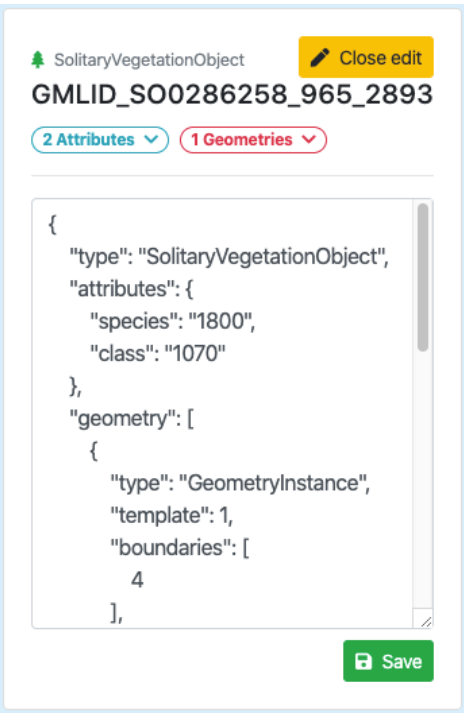
Figure 2. With ninja , it is possible to edit the raw JSON and save it via the info box on an object-by-object basis. Due to the architecture of the application, it is possible to eas- ily swap components in the future. For instance, currently the viewer is based on threejs , but it could be easily pos- sible to have another implementation for other 3D libraries